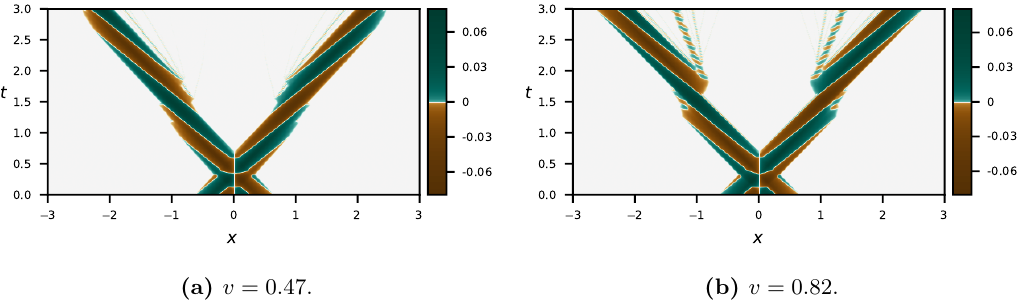
Figure 15 . The scattering of oscillons (antisymmetric con(cid:12)guration) in dependence on parameter v . The initial con(cid:12)guration contains oscillons with speed V = 0 : 8 and (cid:11) =